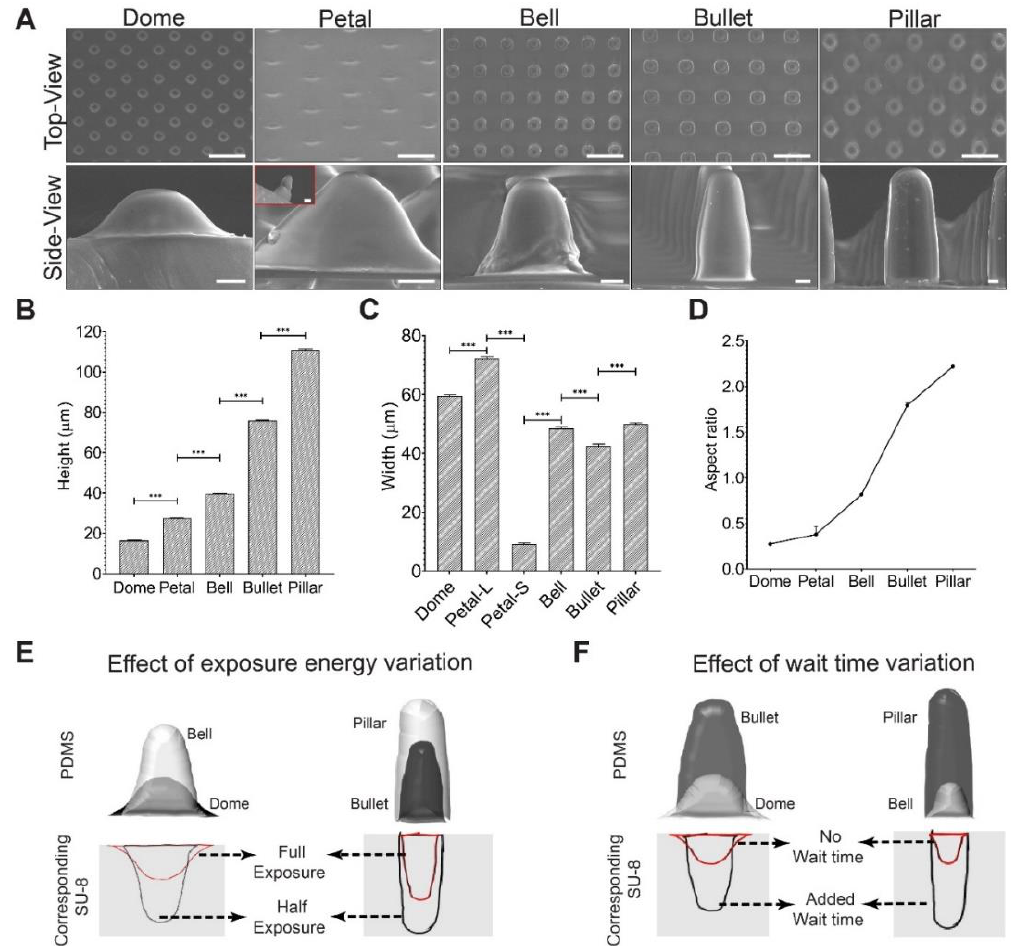
Figure 2. SEM characterization of the PDMS-MSA shape. ( A ) SEM images of the various DEL-MSAs. Petal side-view inset shows the shorter width of the sample viewed from the orthogonal direction, which is much thinner and thus rendering a petal shape. The distribution of ( B ) heights, ( C ) widths and ( D ) the aspect ratios of all fabricated microstructures are shown. Petal is anisotropic in widths. Petal-L and Petal-S denote the longest (72.16 ± 0.612 μm) and the shortest (9.432 ± 0.17 μm) widths, respectively. ( E ) Effect of exposure energy on the microstructure profile. Higher exposure yielded more overcut in SU-8, resulted in shorter and more tapered MSAs. ( F ) Effect of wait time. The addition of wait time leads to much taller and less tapered MSAs. Error Bars: ( B – D ) STDEV. Statistical analysis: ( B , C ) Student’s t -test between groups (*** represents p < 0.001). Scale Bar: ( A ) top: 100 μm; bottom: 10 μm.